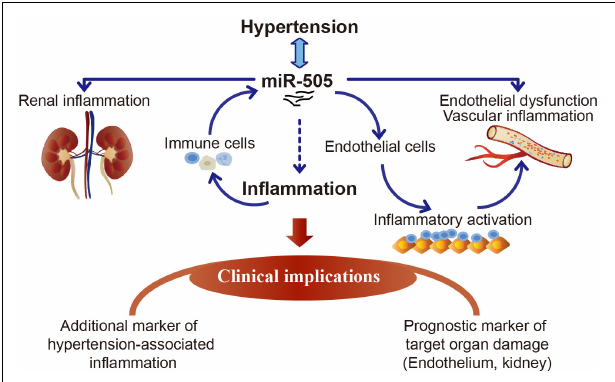
FIGURE 8 | A schematic drawing of the potential clinical implications of miR-505 in hypertension. Elevated circulating miR-505 leads to raised blood pressure, endothelial dysfunction, vascular inflammation, kidney inflammation and pre-activation of peripheral mononuclear immune cells. The functional involvement of miR-505 in inflammation may partially explain its potential implications in hypertension-associated endothelial dysfunction and inflammation in target organs such as the kidney. MiR-505 can be upregulated by pro-inflammatory stimuli in mononuclear immune cells. Meanwhile, miR-505 augments the inflammatory response in mononuclear immune cells, which may promote the inflammatory injuries in target organs. In addition, miR-505 mediates endothelial inflammatory activation in a cell-autonomous manner, which may cause endothelial dysfunction and contribute in part to blood pressure